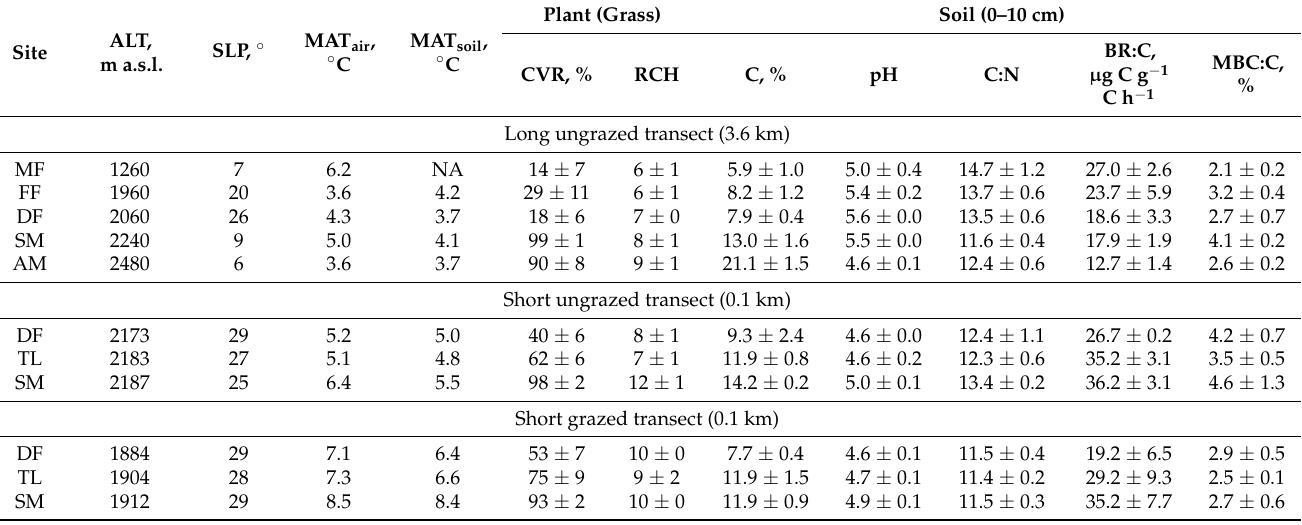
Table 1. Characteristics of mountain forest and meadow sites (MF, mixed forest; FF, fir forest; DF, deciduous forest; SM, subalpine meadow; AM, alpine meadow; TL, tree line) along long and short transects with different land use. Data are means ± standard error ( n = 3).